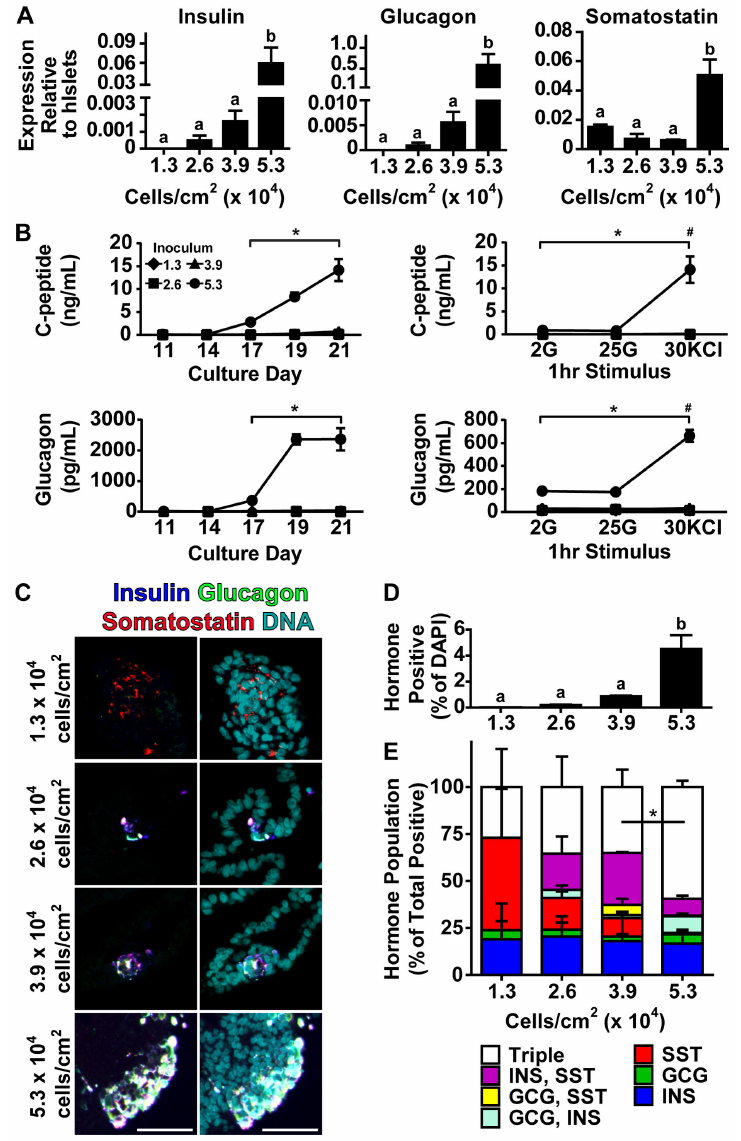
Figure 4. Higher Cell Seeding Density Enhances Pancreatic Endocrine Formation. (A) Insulin, glucagon, and somatostatin expression were assessed in 21 day differentiated hESCs using RT-qPCR (shown relative to human islets). (B) C-peptide and glucagon release were assayed in static 24 hour media samples take on the indicated culture, or during a sequential glucose and/or potassium chloride (KCl) stimulated hormone release assay performed on day 19 of culture. Following a 2 hour 2 mM glucose wash, cells were treated for 1 hour with 2 mM glucose (2G), 25 mM glucose (25G), then 30 mM KCl (30KCl). Diamonds, squares, triangles, and circles represent 1.3 x 10 4 cells/cm 2 , 2.6 x 10 4 cells/cm 2 , 3.9 x 10 4 cells/cm 2 , and 5.3 x 10 4 cells/cm 2 initial seeding density respectively. * represents p<0.05 comparing 5.3 x 10 4 cells/cm 2 with other cell densities. # represents p<0.05 comparing KCl stimulation versus other stimuli within the 5.3 x 10 4 cells/cm 2 seeding density. (C) hESCs seeded at different densities and differentiated for 21 days were agarose-embedded and immunostained for insulin (blue), glucagon (green), somatostatin (red) and DNA (cyan). Right panel shows hormone staining and left panel shows the same hormone image with DNA. See Figure S4 for single channel images of a larger field of view. (D) Single-cell quantification of hormone population showing the number of cells positive for insulin, glucagon, or somatostatin as a percentage of the total number of nuclei. (E) Single-cell polyhormonal analysis of the hormone positive population in C as a percentage of total hormone positive population. Triple indicates cells scored positive for all three hormones. * represents p<0.05 comparing triple positive populations of 5.3 x 10 4 cells/cm 2 vs 3.9 x 10 4 cells/cm 2 . In panels A and D, different superscripts (a, b) are significantly different from each other within each graph by one-way ANOVA with Bonferroni post-hoc test. Scale bars are 50 μm. doi: 10.1371/journal.pone.0082076.g004 PLOS ONE |